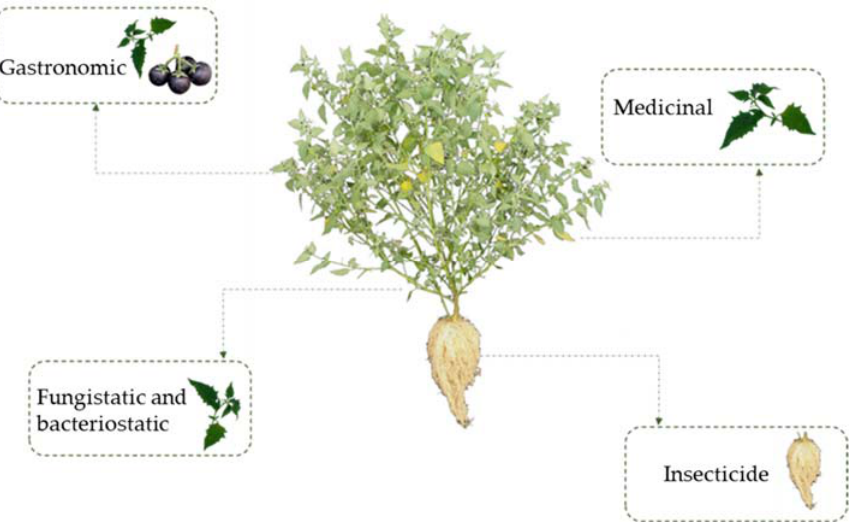
Figure 4. Main uses of slender nightshade plant ( Solanum nigrescens ). Photos by Sara Monzerrat Ramírez-Olvera.